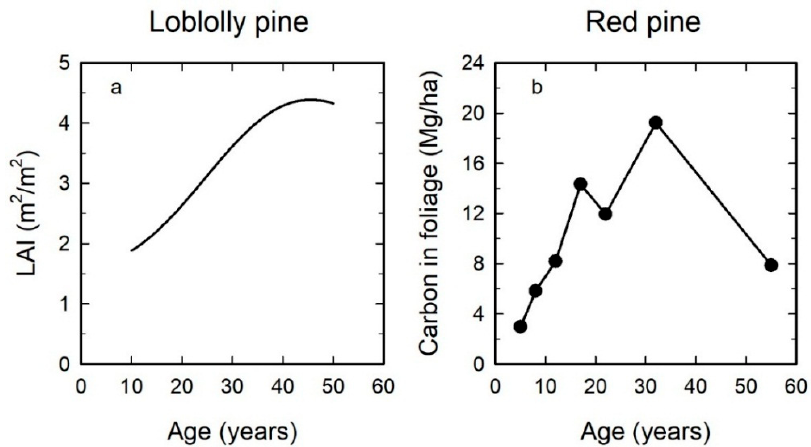
Figure 3. Comparison of accumulated leaf area calculated from the biomechanical model of Dean et al. [15] for a loblolly pine plantation started at 1200 trees/ha on land with site index = 18 m at 25 years ( a ) and measured accumulation of carbon in leaf mass for a chronosequence of a red pine plantation as reported by King et al. [72] ( b ) with an average tree density of 1750 trees/ha. The oldest red pine stand had been thinned to 622